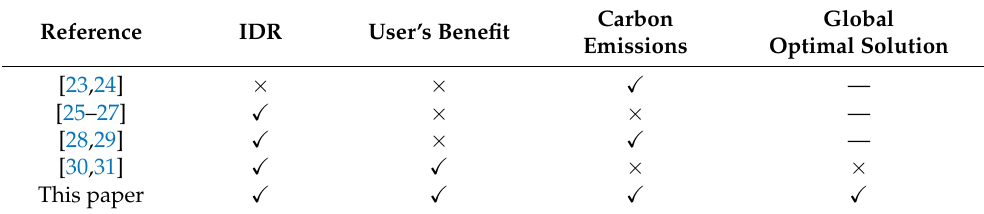
Table 1. The comparison of some